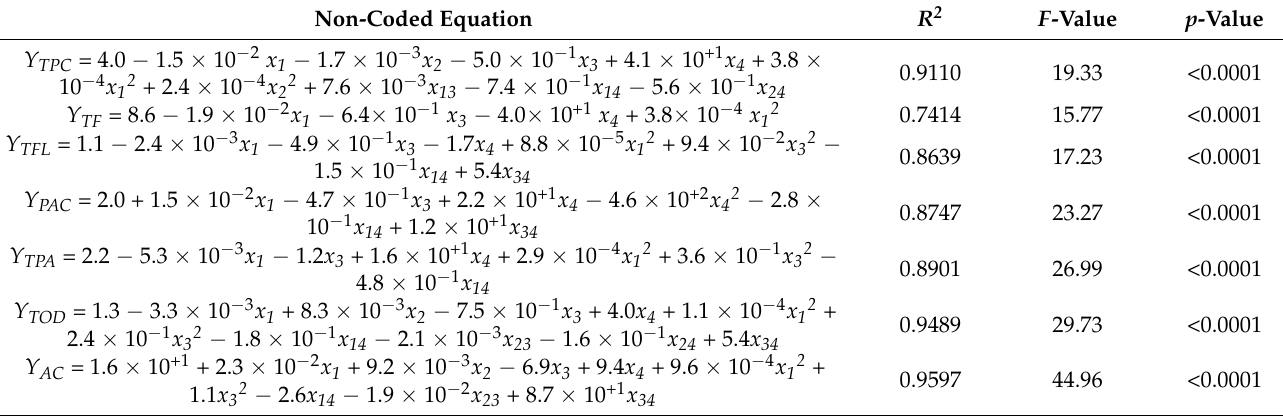
Table 4. Non-coded equations and their statistical parameters for the extraction of total phenolic compounds (TPC), total flavonoids (TF), total flavanols (TFL), total proanthocyanidins (PAC), total phenolic acids (TPA), total o -diphenols (TOD), and the in vitro antioxidant capacity